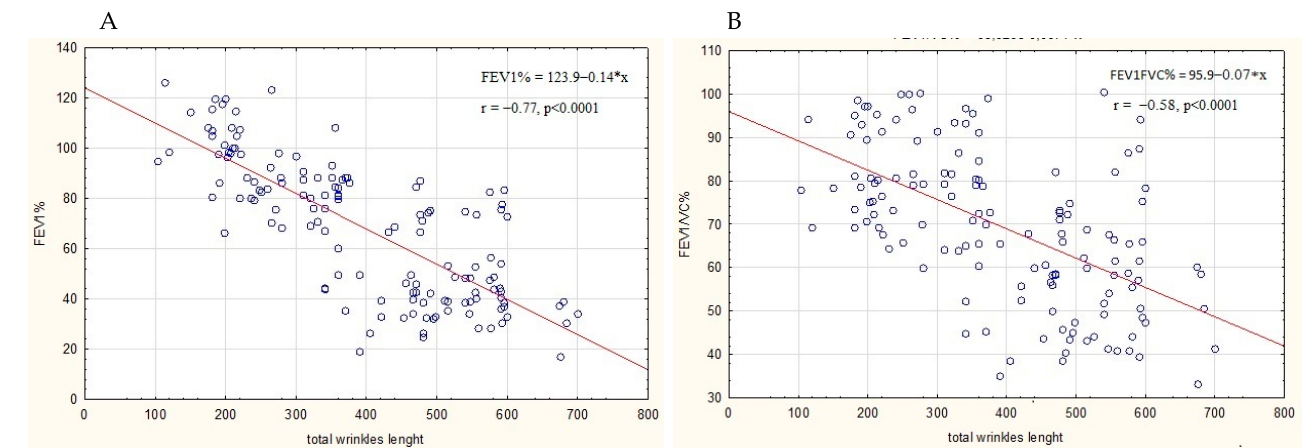
Figure 2. Relationships between total wrinkle length and lung function parameters: ( A ) FEV1% and ( B ) FEV1/FVC.